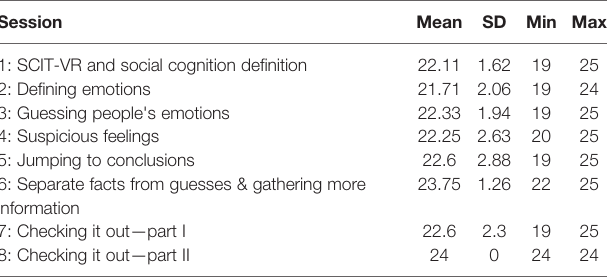
TABLE 3 | Total acceptability ratings (0 – 25) for each session of VEEP. TABLE 4 | Feedback and illustrative